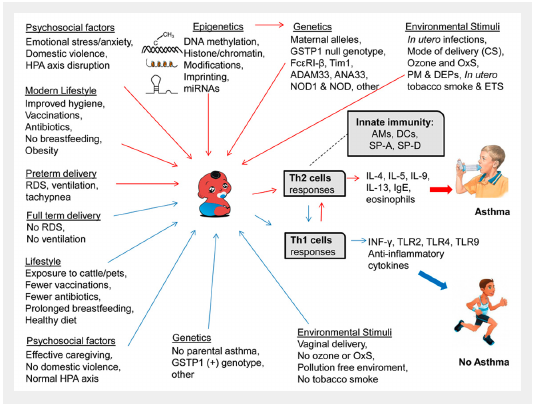
Diagrammatic summary of childhood asthma causes, risks and protective factors. The figure depicts the causes and the risk factors of childhood asthma that include genetics, epigenetics and environmental insults. These favour the Th2 biased cell response and select against Th1 cell response leading to inflammation and exacerbation of asthma (red arrows). The figure shows the factors leading to the Th1 cell response that produces anti-inflammatory cytokines and these in turn protect against asthma (blue arrows). The role of innate immunity in asthma, as exemplified by AMs, DCs, SP-A and SP-D is also noted with a broken line. The human